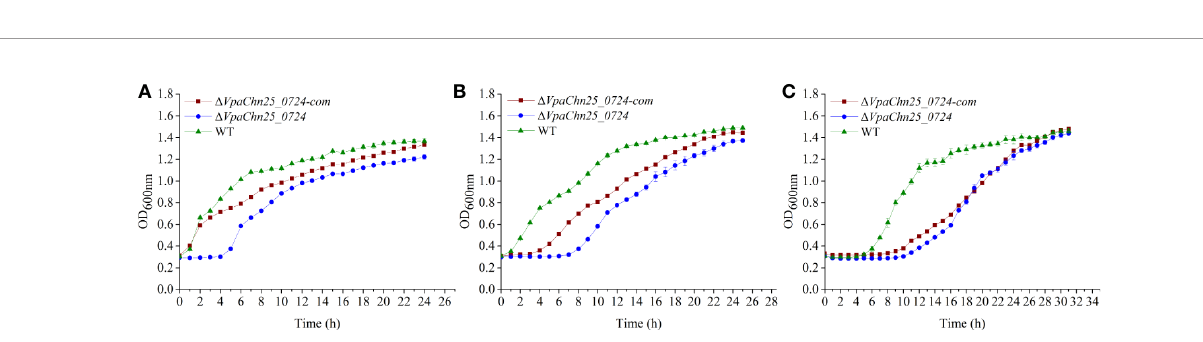
FIGURE 1 | Gene organization of the Vibrio phage Martha 12B12-like sequence in chromosome 1 of V. parahaemolyticus CHN25 genome. Genes in gray color represent predicted hypothetical proteins, and those in red represent additional proteins absent from the Vibrio phage Martha 12B12. The VpaChn25_0724 gene was marked with a star in